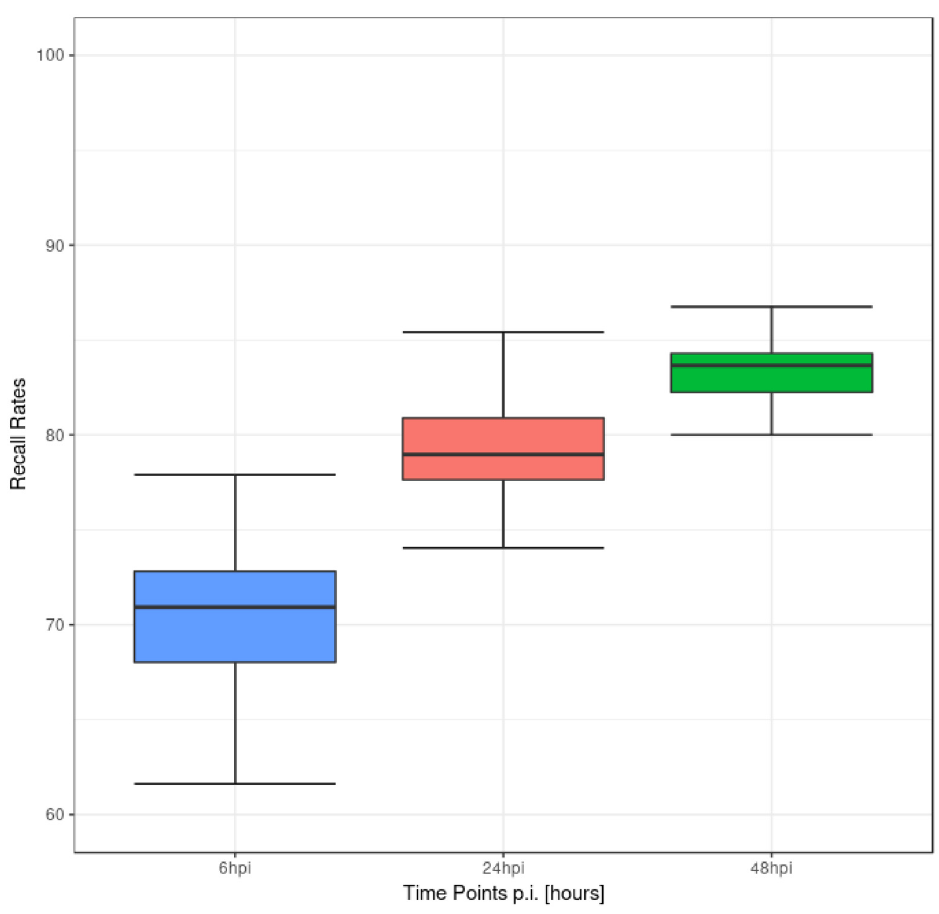
Figure 3. Recall rates for genes in MSF identified sub-graph for the three different time points of EBOV infection data for 100 simulations where Poisson distributed noise was added to the experimentally deduced reads per